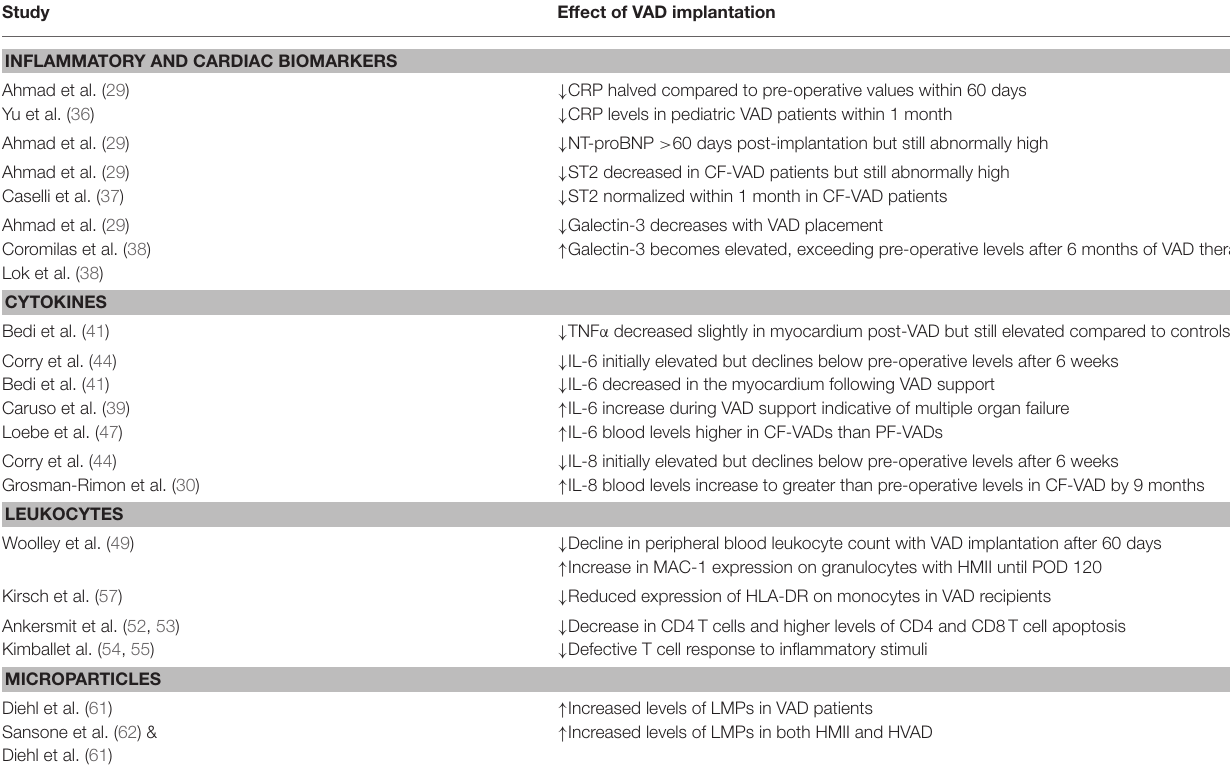
TABLE 1 | The effect of VAD implantation on inflammatory parameters. Study Effect of VAD implantation INFLAMMATORY AND CARDIAC